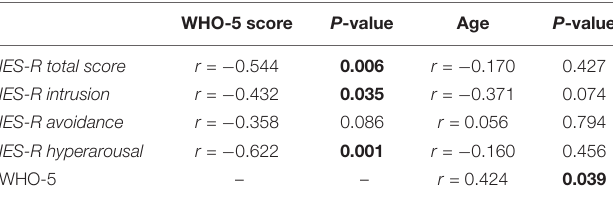
TABLE 3 | Alpha coefficients, subscale means, and test-retest reliability of IES-R subscales. Subscales